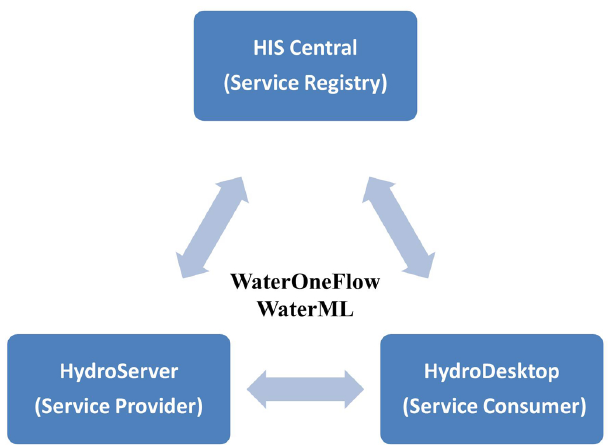
Fig. 3. Services-oriented architecture for